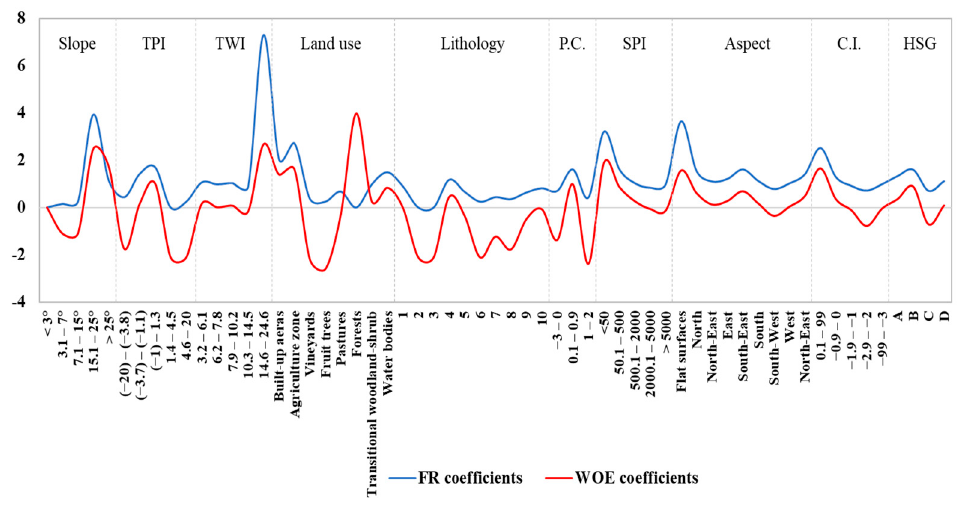
Figure 6. Distribution of FR and WOE coefficients within the classes of flash-flood predictors.